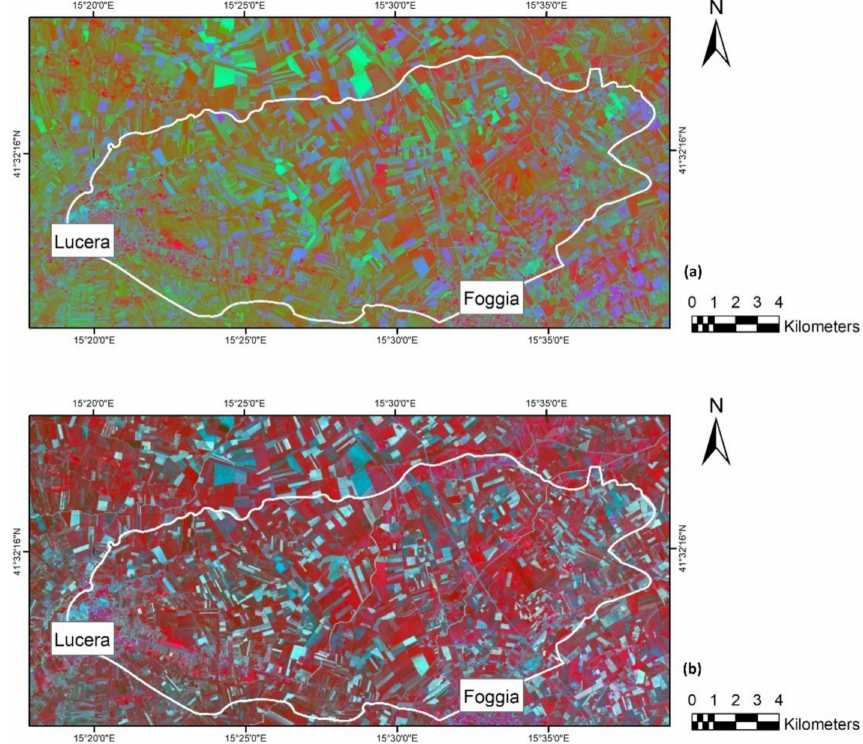
Figure 7. RGB produced using Tasseled Cap Transformation (TCTs) equations: ( a ) R: TCT brightness (2), G: TCT greenness (3), B: TCT wetness (4); ( b ) R: TCT brightness (5), G: TCT greenness (6), B: TCT wetness